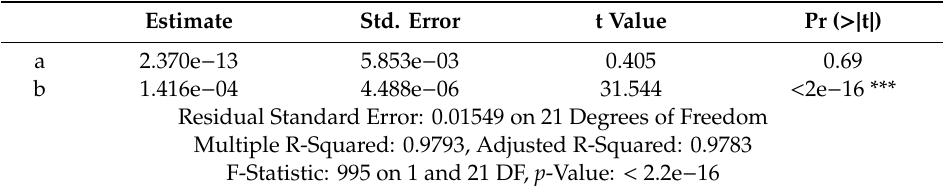
Table 11. Statistical parameters for the power regression model Y = a + b · X3 1.366 . Estimate Std.